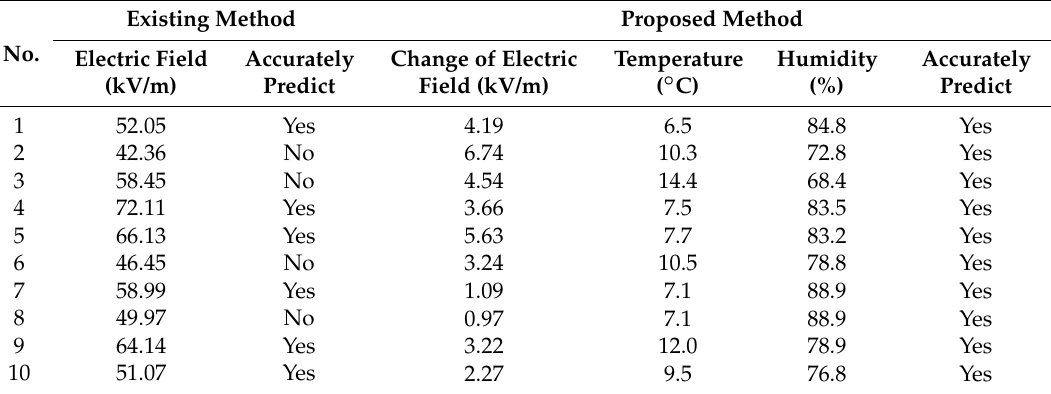
Table 1. Example of comparison of lightning prediction accuracy between existing and proposed